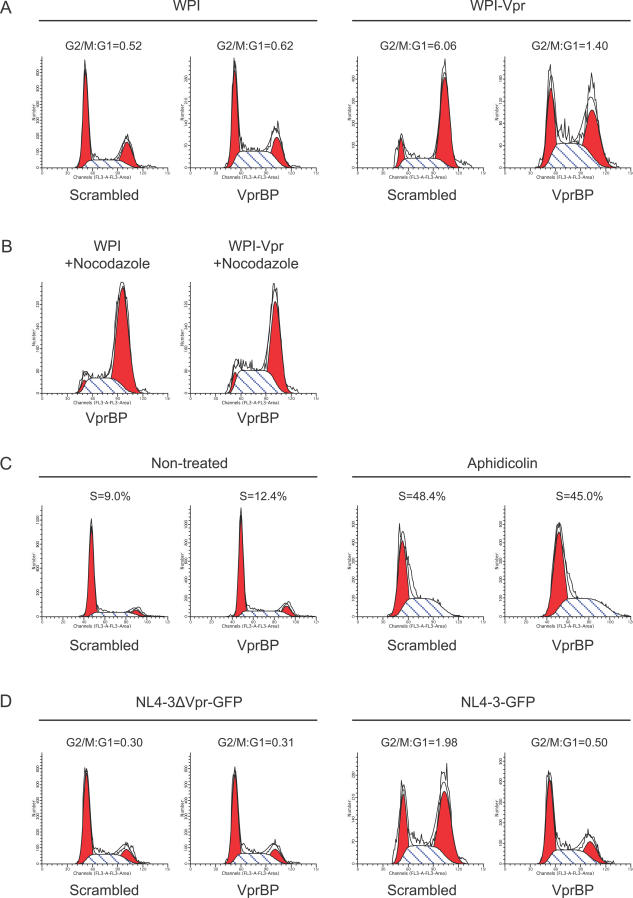
Effect of VPRBP Depletion on Vpr-Induced G2 Arrest(A) HEK293 cells were transfected with 300 pmol of VPRBP-targeting siRNA or control scrambled siRNA using Oligofectamine, followed by the same transfection 24 h later. Twenty-four hours after the second siRNA transfection, cells were transduced at a multiplicity of infection of 1 with lentiviral vectors expressing Vpr (WPI-Vpr) or the empty vector (WPI). Cell cycle profiles were analyzed 24 h after transduction by flow cytometry using propidium iodide staining.(B and C) To determine if cell growth (B) or checkpoint activation (C) was affected by VPRBP knockdown, HEK293 cells were transfected once with siRNA, as described above, and treated respectively with 1 μg/ml nocodazole and 0.5 μM aphidicolin 24 h later. Cell cycle profiles were analyzed 24 h after drug treatment.(D) To determine if VPRBP knockdown could also abrogate the induction of G2 arrest in the context of viral infection, siRNA-transfected cells were infected with NL4.3-GFP and NL4–3ΔVpr-GFP at a concentration of 100 cpm/cell and cell cycle profiles were analyzed 48 h later.Percentages of G1 and G2/M cell populations were determined using the ModFit software. These results are representative of the data obtained in at least two independent experiments.